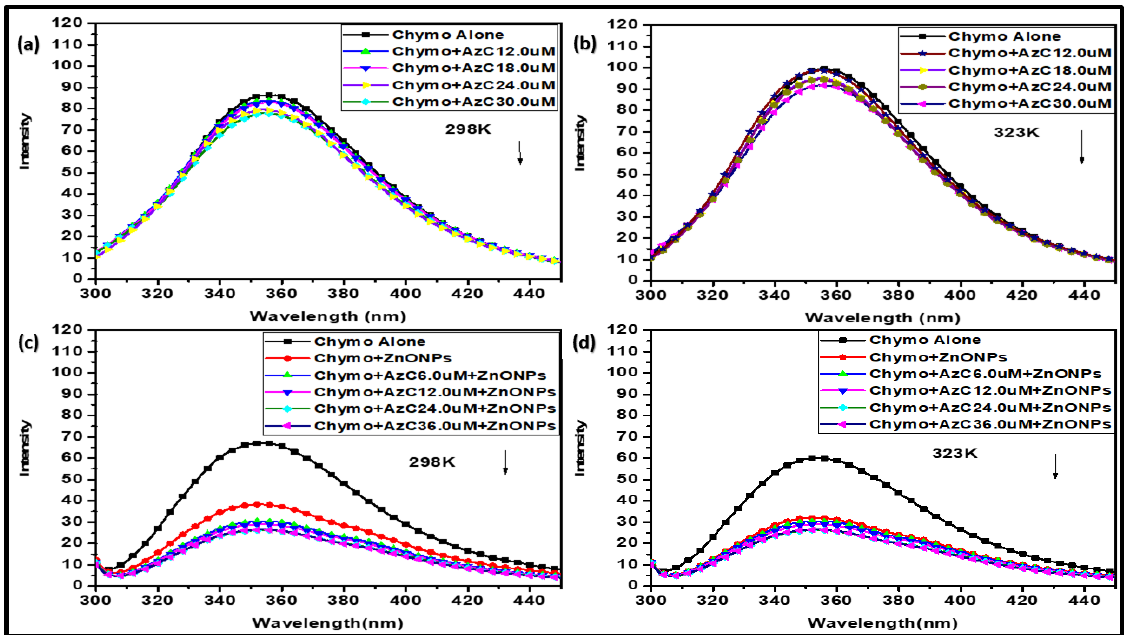
Figure 4. Fluorescence spectra of Chymo in presence of AzC at 298 K ( a ) & 323 K ( b ); and AzC- ZnONPs complex at 298 K ( c ) & 323 K ( d ).